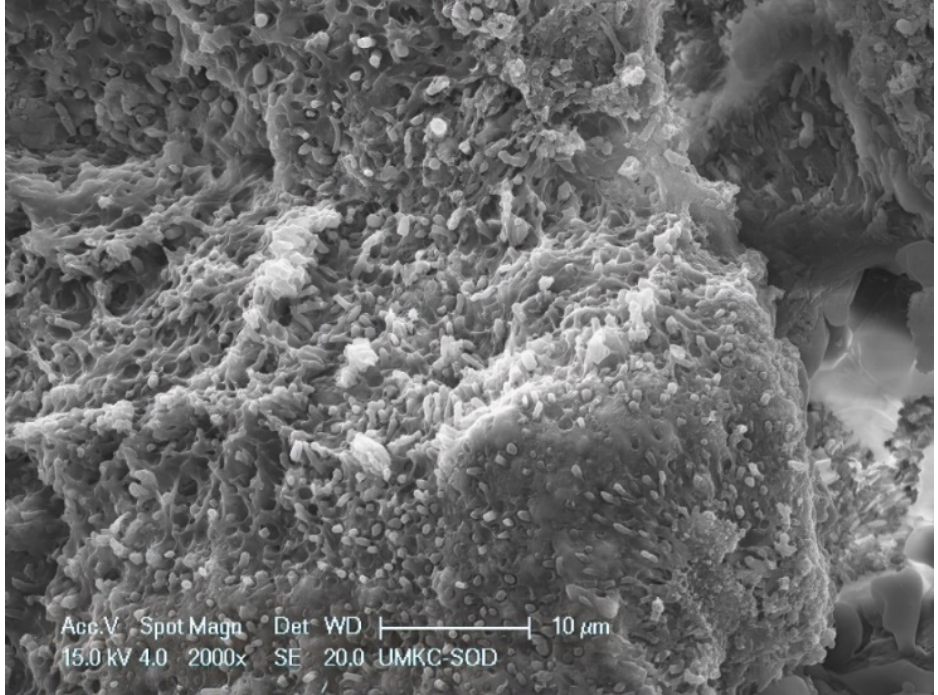
Figure 2. Untreated root surface showing calculus of a calculus shelf covered with biofilm. Note bacteria embedded in extra-cellular matrix of the lateral wall of the calculus shelf. Original magnification of 2000×; Bar = 10 μ m.